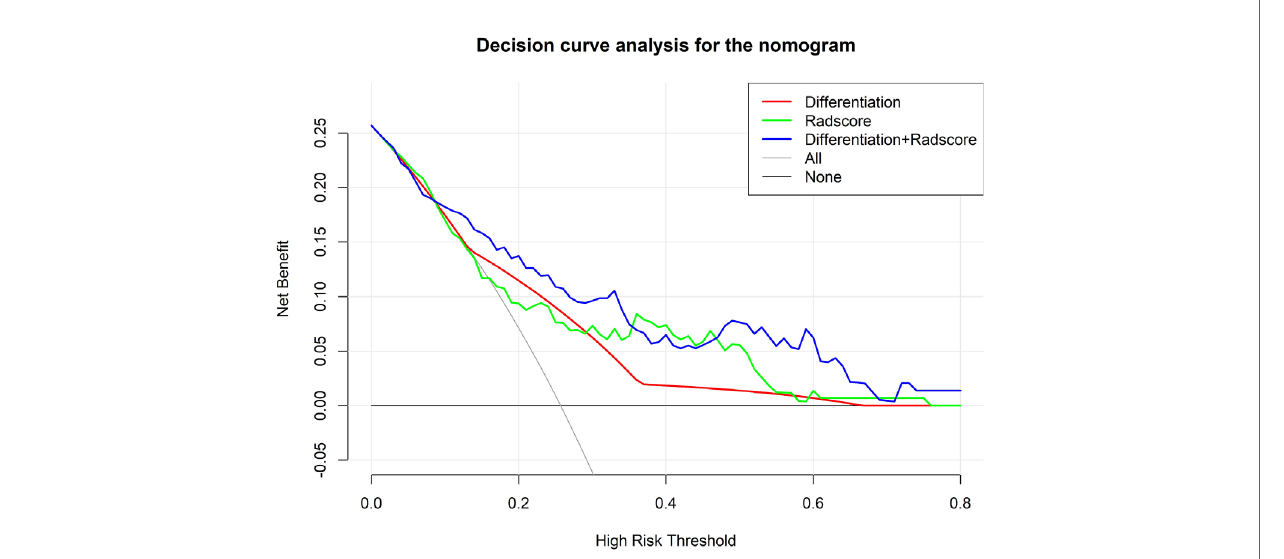
FIGURE 6 | Decision curve analysis comparing the predictive value of different models. The Y-axis measures the net bene fi ts. The X-axis represents the threshold probability for “ positive ” (indicating the patient is likely to achieve a major response after NAC and should be recommended for NAC). The green line represents predictions based on only radscores. The red line represents predictions based on only adenocarcinoma differentiation. The purple line represents predictions based on the model incorporating both radscores and differentiation. As shown in the fi gure, in most thresholds, the integrated model demonstrates superiority and more net bene fi t gains.